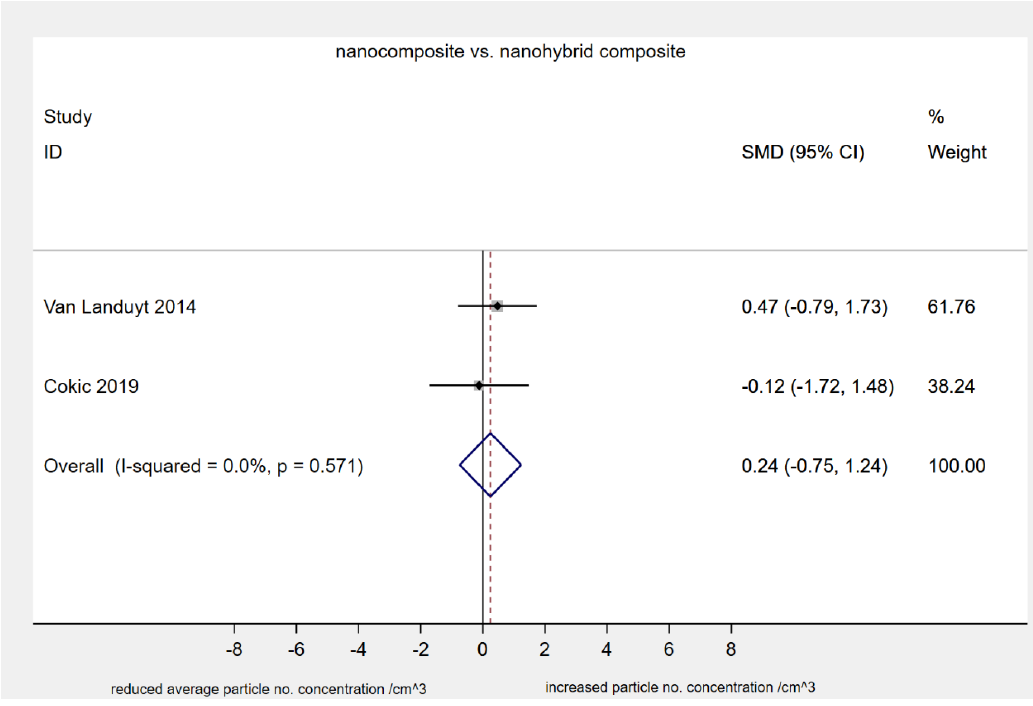
Figure 3. Standardized mean differences in average particle number concentration (#/cm 3 × 10 6 ), (nanocomposite, Filtek Supreme XTE; nanohybrid, GradiO).